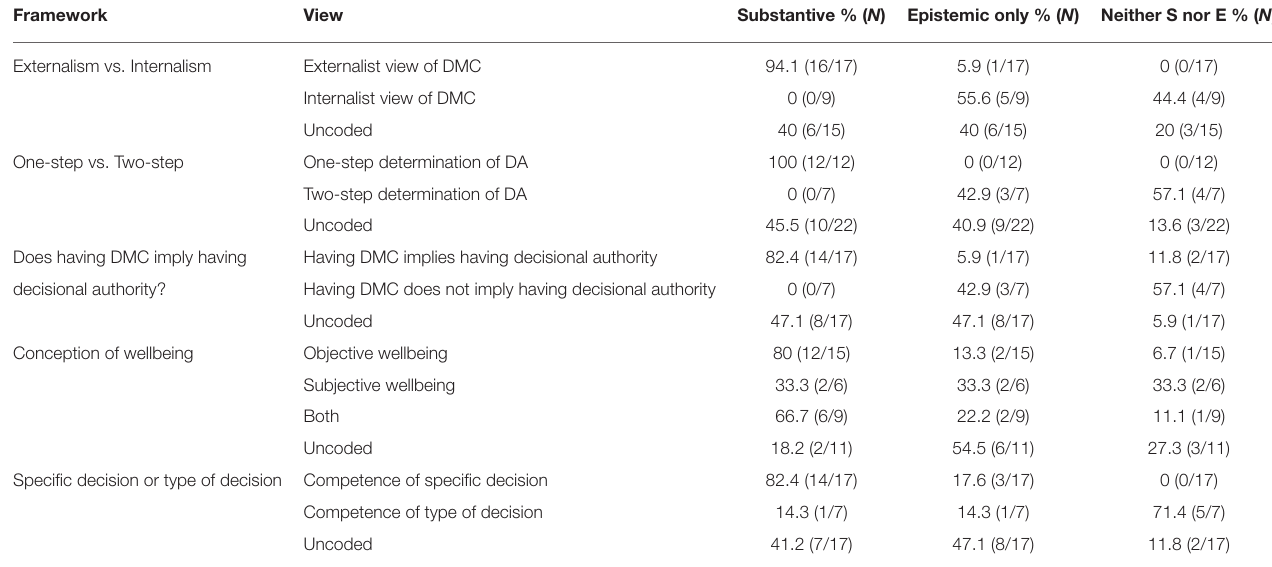
TABLE 6 | Relationship of frameworks to stance on